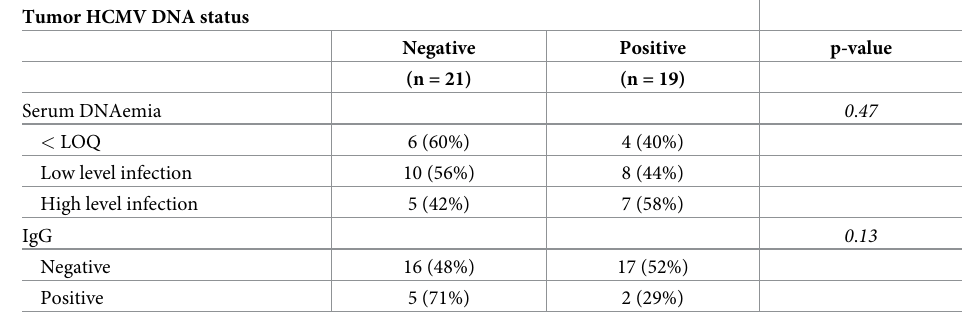
Table 2. Association between tumor and serum biomarkers of HCMV in MPM patients (n =